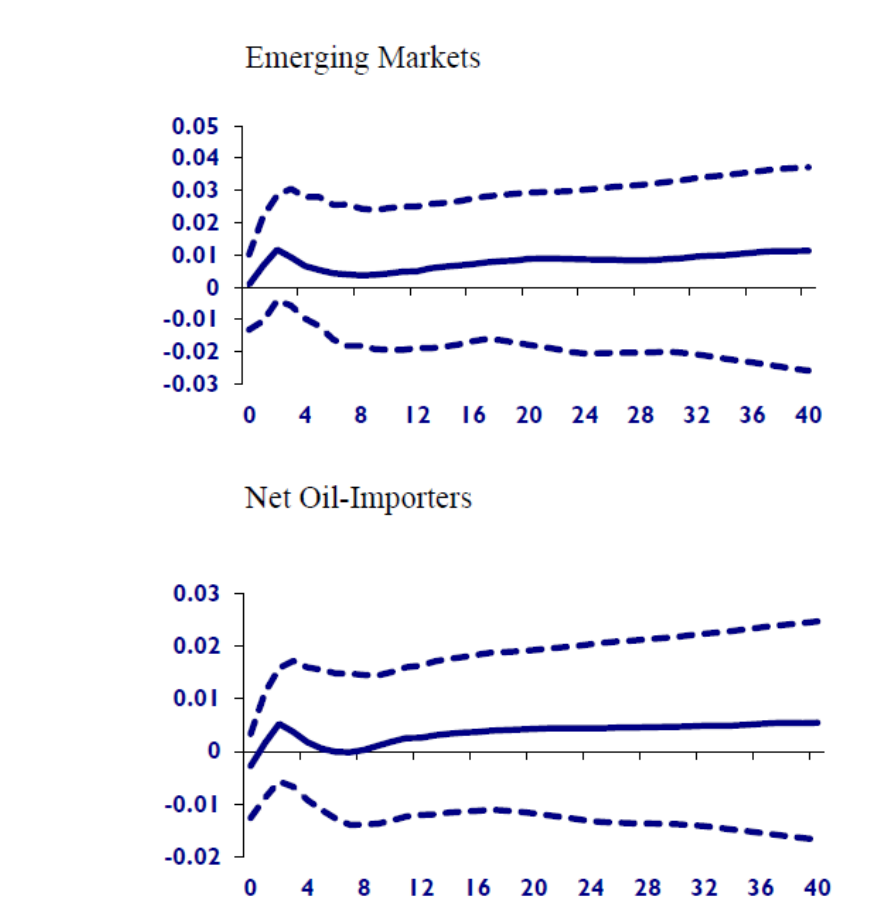
Figure 8. GARCH-based oil price uncertainty shocks and real stock prices ( country groups ). Note: The figure depicts the impulse response functions of real stock prices of country groups to a one standard deviation increase in oil price uncertainty. The median impulse response is presented in solid lines, while the 16–84% lower and upper bootstrapped error bands are shown in dotted lines. The impact is measured in percentage points (by multiplying the estimates in the figure by 100) over the quarterly horizon.